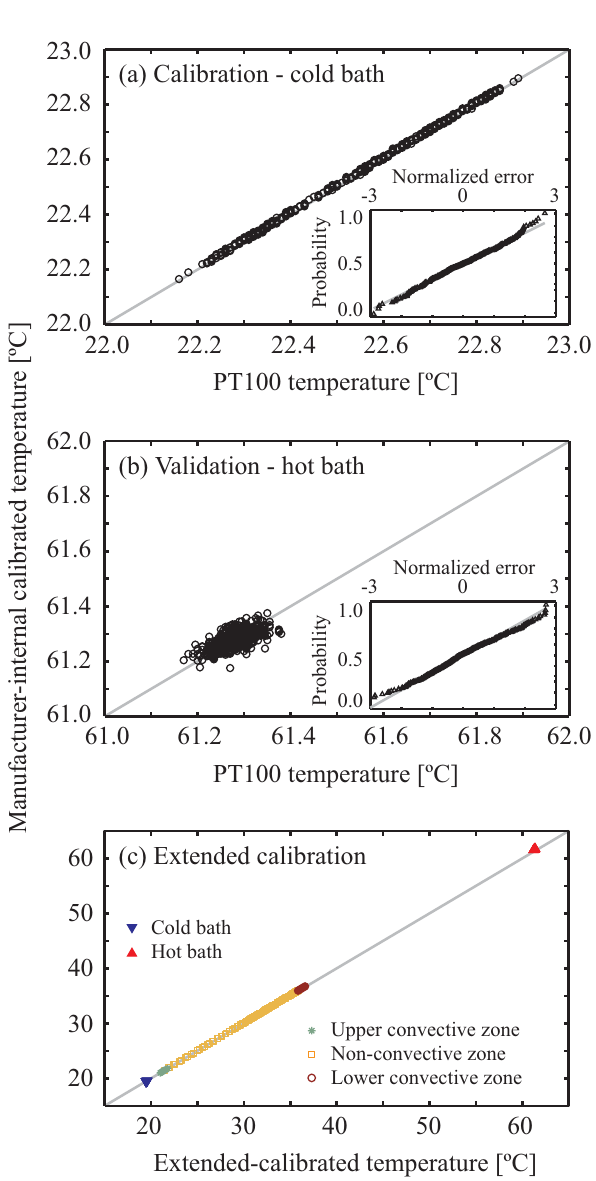
Fig. 3. (a) The DTS system is calibrated by comparing the PT100 temperature measurements with the DTS manufacturer-internal cal- ibrated temperatures in the cold bath. (b) The DTS system is vali- dated in the hot bath. (c) Extended- and manufacturer-internal cali- brated temperatures are